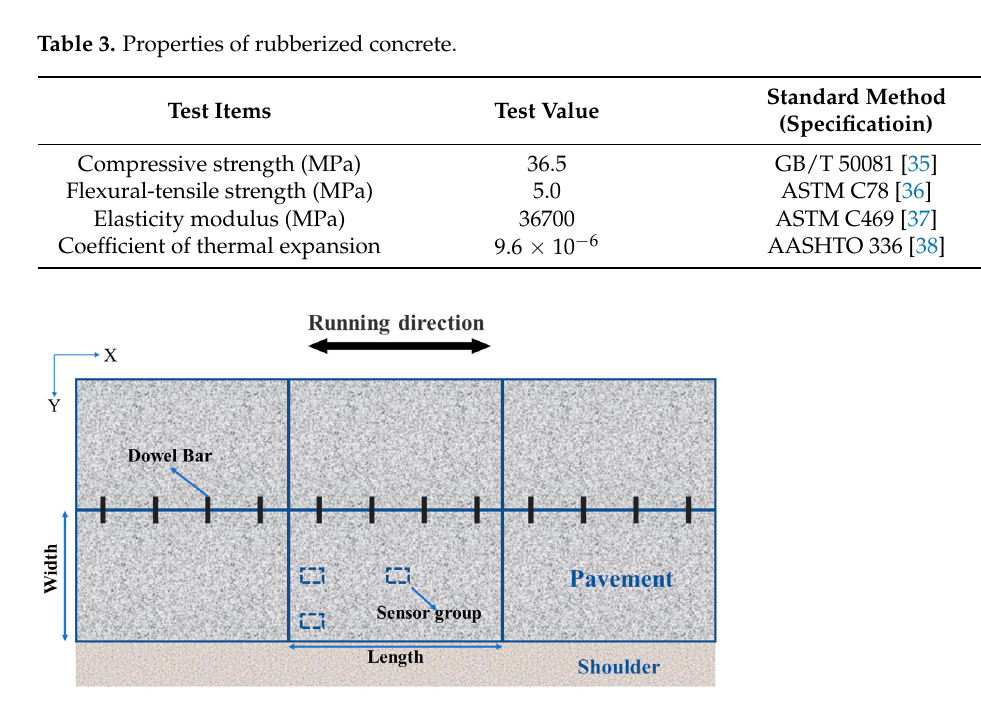
Figure 1. Schematic diagram of pavement in test area.